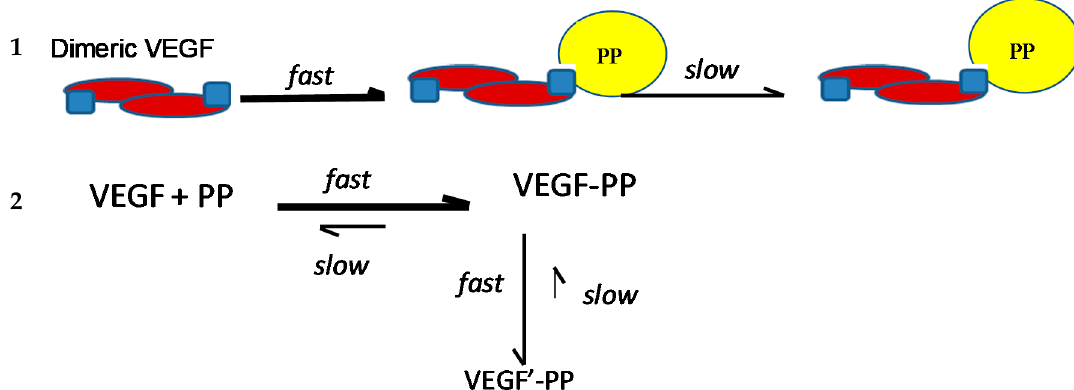
Figure 6. Possible models for binding between VEGF and polyphenols (PP).